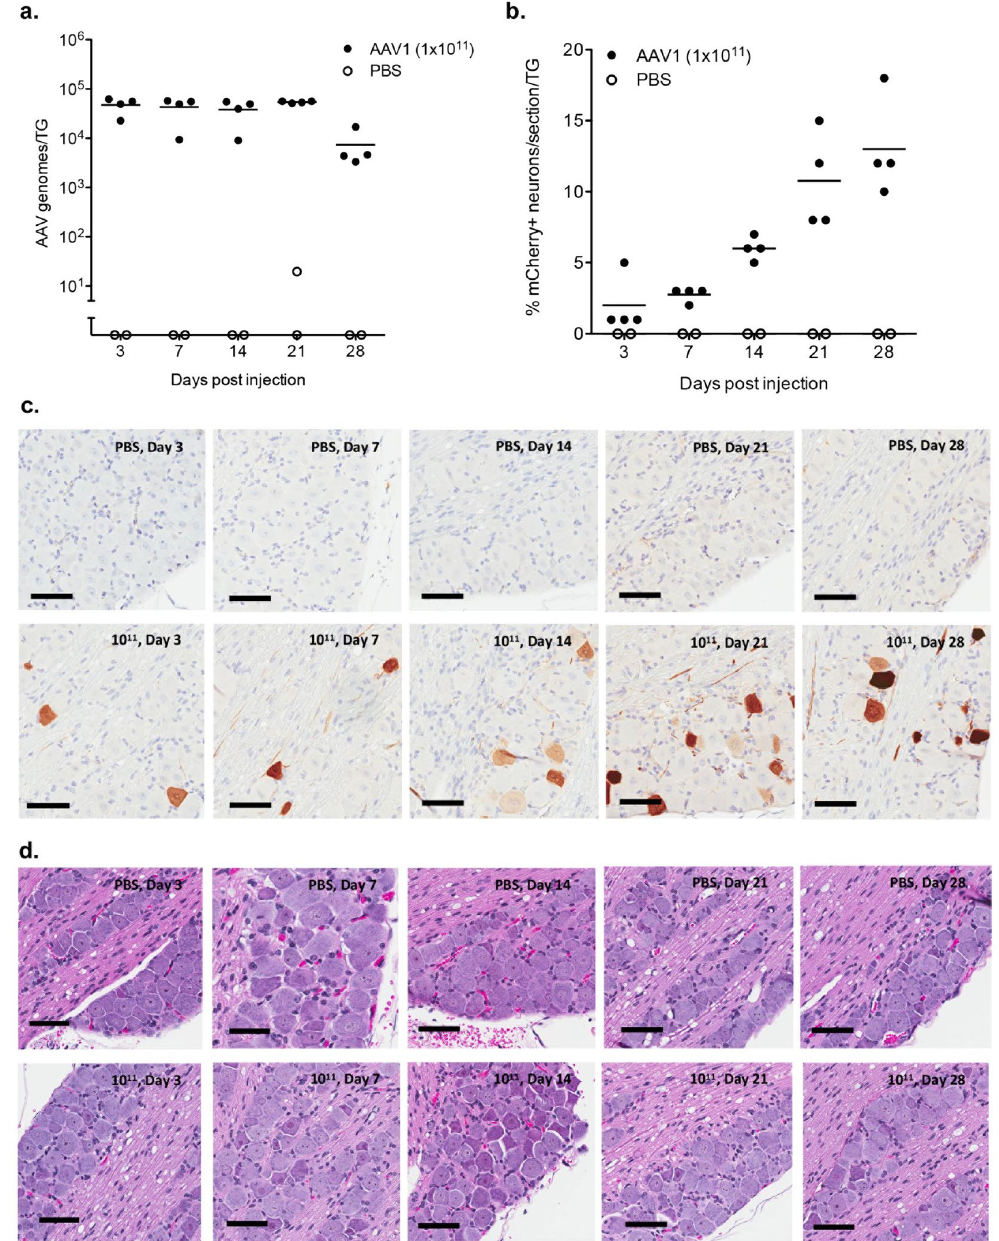
Figure 4. Longitudinal kinetics of scAAV1 gene delivery to trigeminal ganglia. Swiss Webster mice were inoculated by intradermal injection of the whiskerpad with PBS or 1 × 10 11 vector genomes of scAAV1-smCBA- mCherry. At days 3, 7, 14, 21, and 28 post-delivery trigeminal ganglia were analyzed for levels of vector genomes by qPCR ( a ) or the percentage of neurons positive for mCherry by immunohistochemistry ( b ). For qPCR each symbol represents one trigeminal ganglion (TG) from a total of either 2 animals for AAV1 or 1 animal for PBS control at each time point. mCherry positive neurons were quantified using Cell Profiler software and each symbol represents the average number of mCherry positive neurons from 5 sections of one individual trigeminal ganglion (TG) from a total of either 2 animals for AAV1 or 1 animal for PBS control at each time point. Representative sections stained by immunohistochemistry for mCherry ( c ) or with hematoxylin/eosin ( d ) are shown from PBS or scAAV1-smCBA-mCherry injected mice. Scale bar: 100 μ